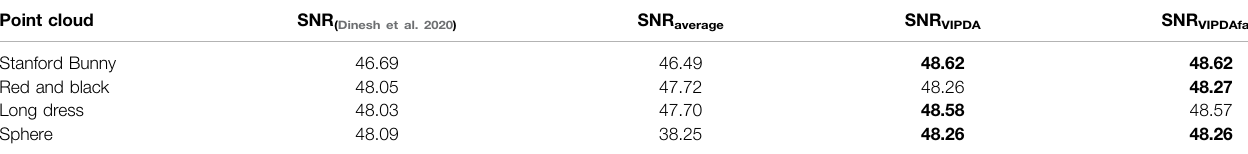
Highest values for each SNR are highlighted in